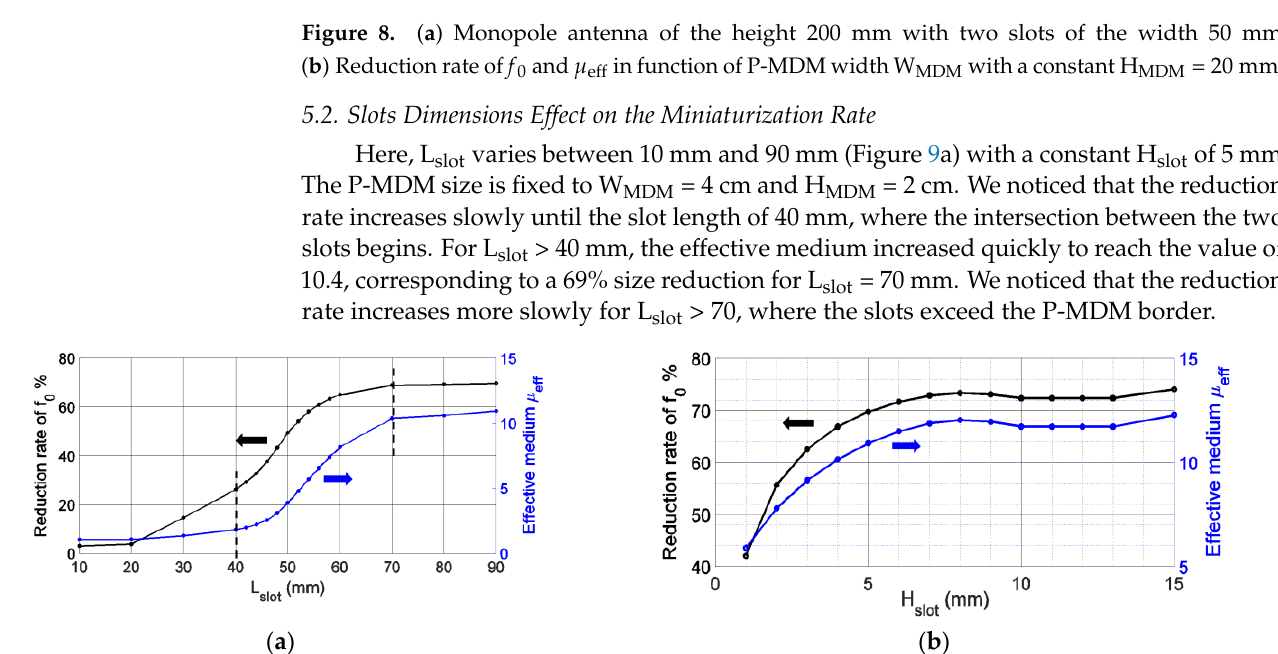
( a ) ( b ) Figure 10. ( a ) Miniaturized monopole antenna A4 by the P-MDM of dimensions 4 × 2 cm with two slots of length 51.3 mm. ( b ) Miniaturized monopole antenna A5 by the P-MDM with two slots of dimensions 93 × 10 mm . 6. Realization and Experimental Validation The antenna A5 was realized with 1 mm thick brass plate and measured using a 1-m diameter ground plane. The two P-MDM of the antenna A5 were integrated into two plas- tic supports to tighten the plates as much as possible on the antenna (see Figure 11). Figure 12 shows the imaginary and real parts of the measured and simulated imped- ance of the antenna A5. There is a good agreement between the results in the band 118 – 156 MHz. The measured antenna resonates almost at the same resonance frequency found in the simulation, which is around 130 MHz. ( a ) ( b ) Figure 11. ( a ) planar monopole A5 realized with two P-MDM. ( b ) Slots and two P-MDM.